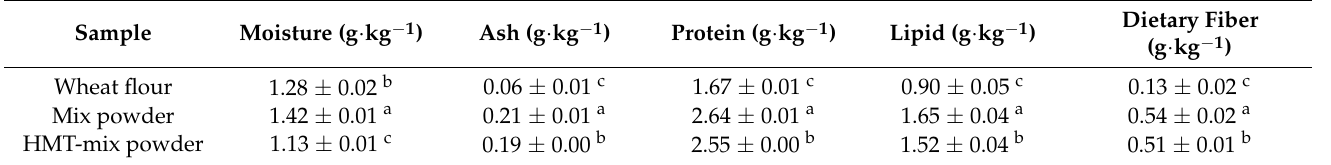
Table 1. Proximate composition of black soybean powder and wheat flour.